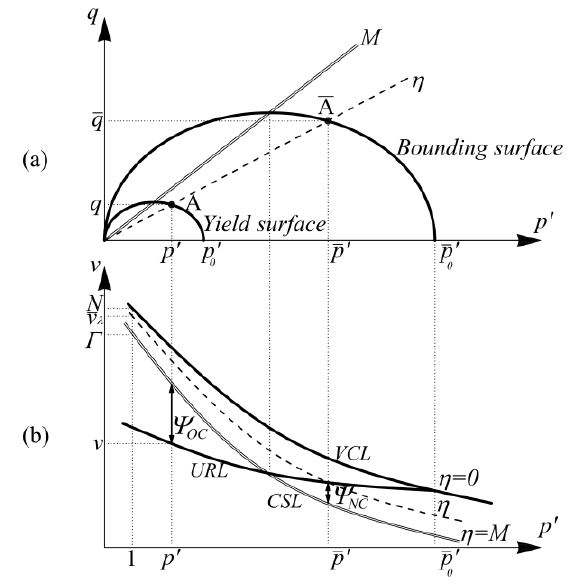
Figure 1. ( a ) Bounding surface concept; ( b ) State parameters [27].